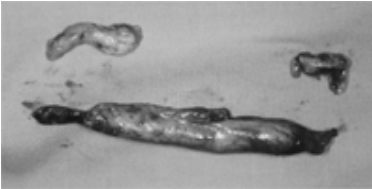
FIGURE 1 . The right spermatic vein with the tumor thrombus. A part of the tumor thrombus that was extracted from the distal spermatic vein can also be seen.